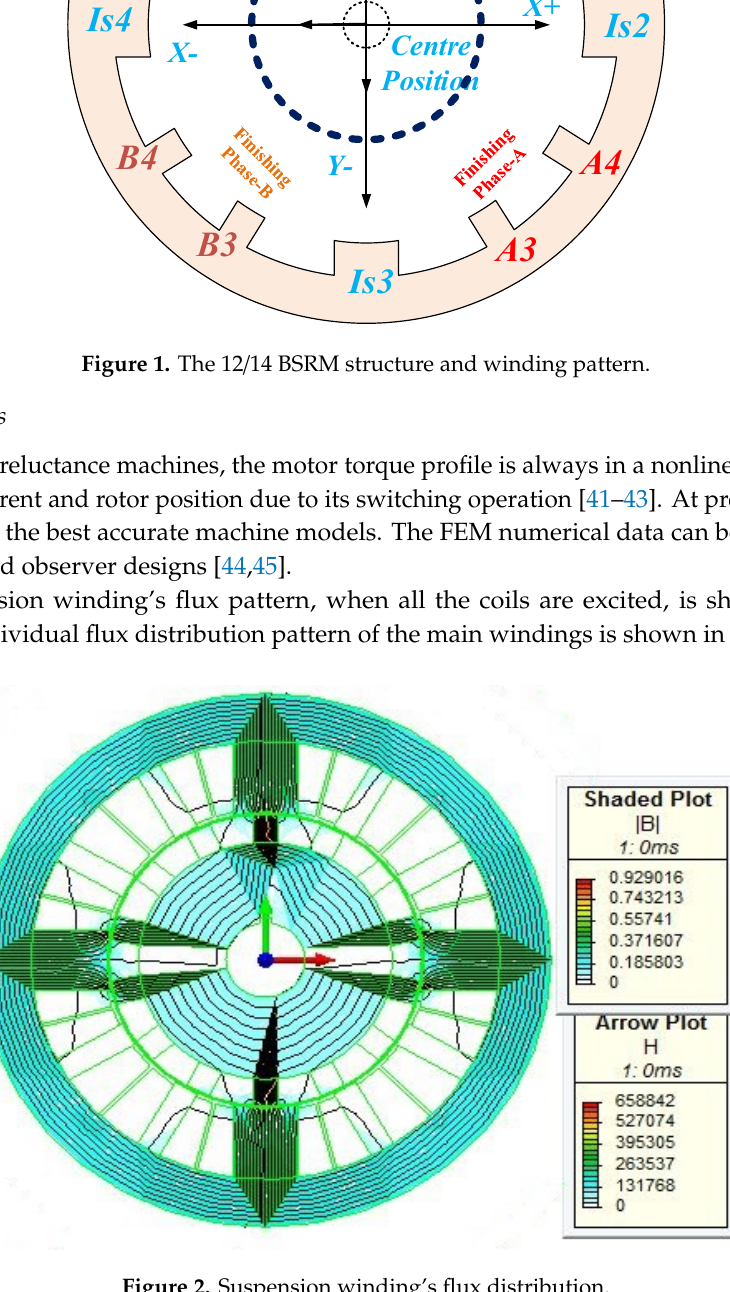
Figure 2. Suspension winding’s flux distribution.